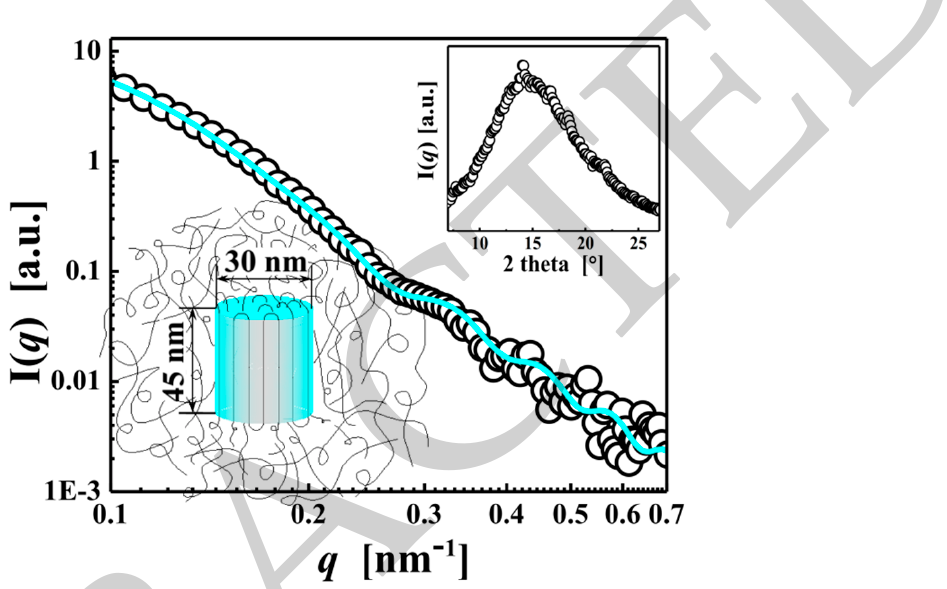
Figure 7. The SAXS scattering profile of iPP, obtained at 170 °C for a holding time of 10 min. The best fit (solid line) is also shown. The corresponding simultaneous WAXS profile and diagrammatic sketch for cylindrical nanocrystals are shown at the right top and left bottom as inset, respectively.